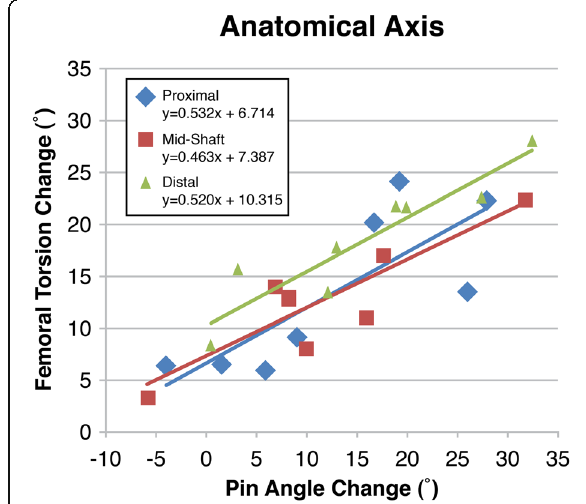
Fig. 5 Change in femoral torsion in the anatomical axis with pin angle, rotation through the osteotomy, change. All correlations are significant (p.0.05)